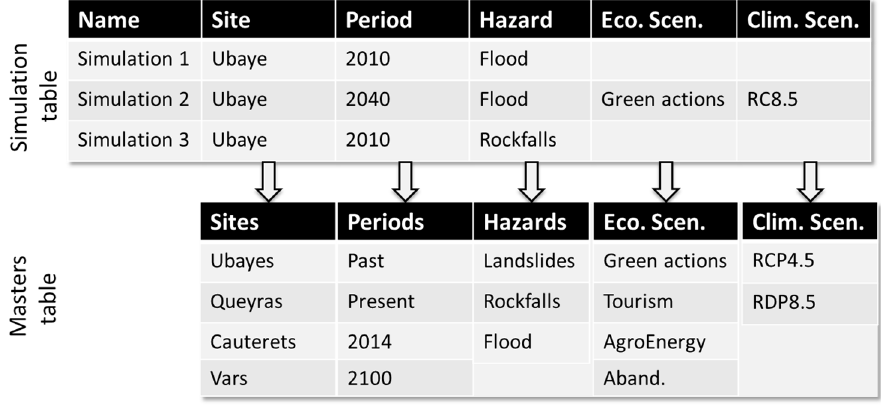
Figure 5. Data storage example used in the SAMCO simulations.